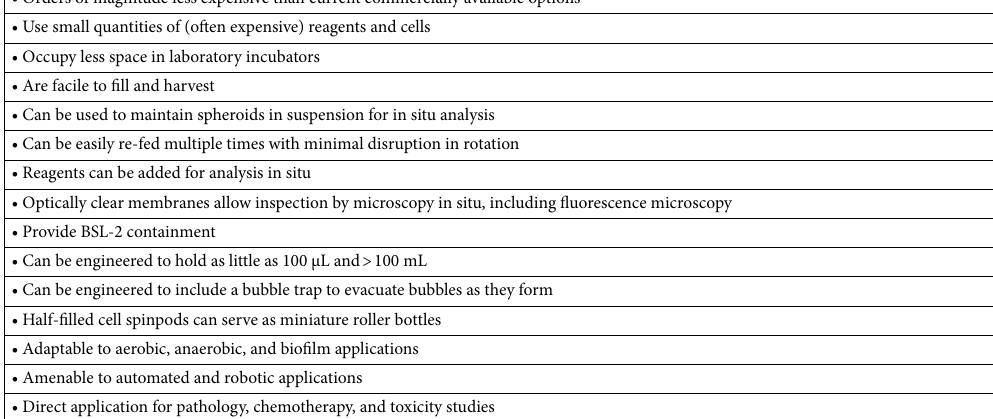
Table 2. Advantages and uses of the cell spinpod form of rotational cell